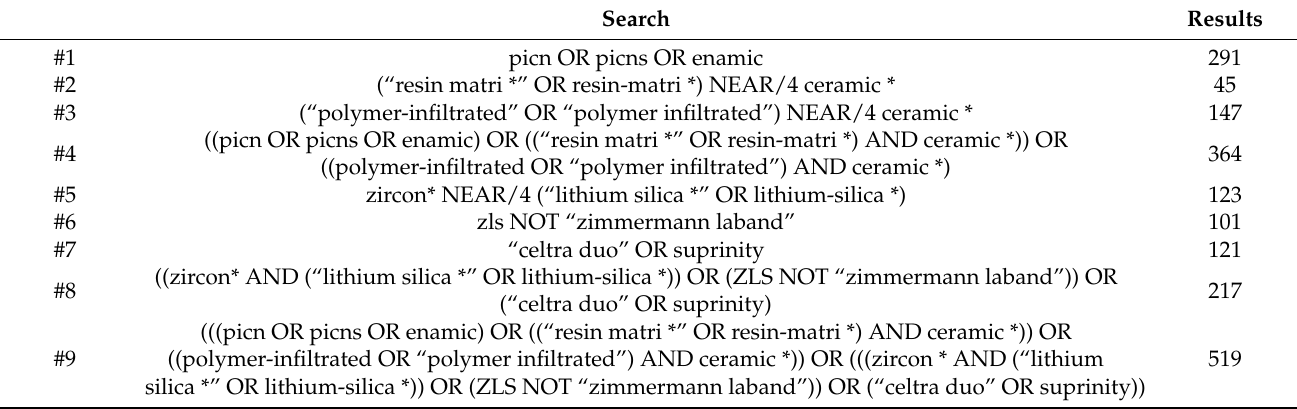
Table 1. Search strategy for